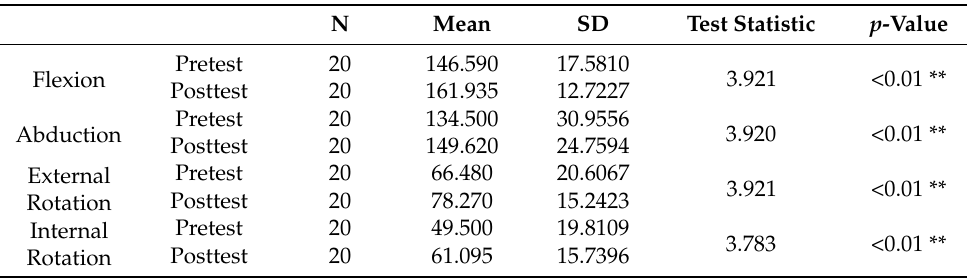
Table 3. Summary statistics and Wilcoxon rank sum test for comparing movement angle measure- ments between pretest and posttest.